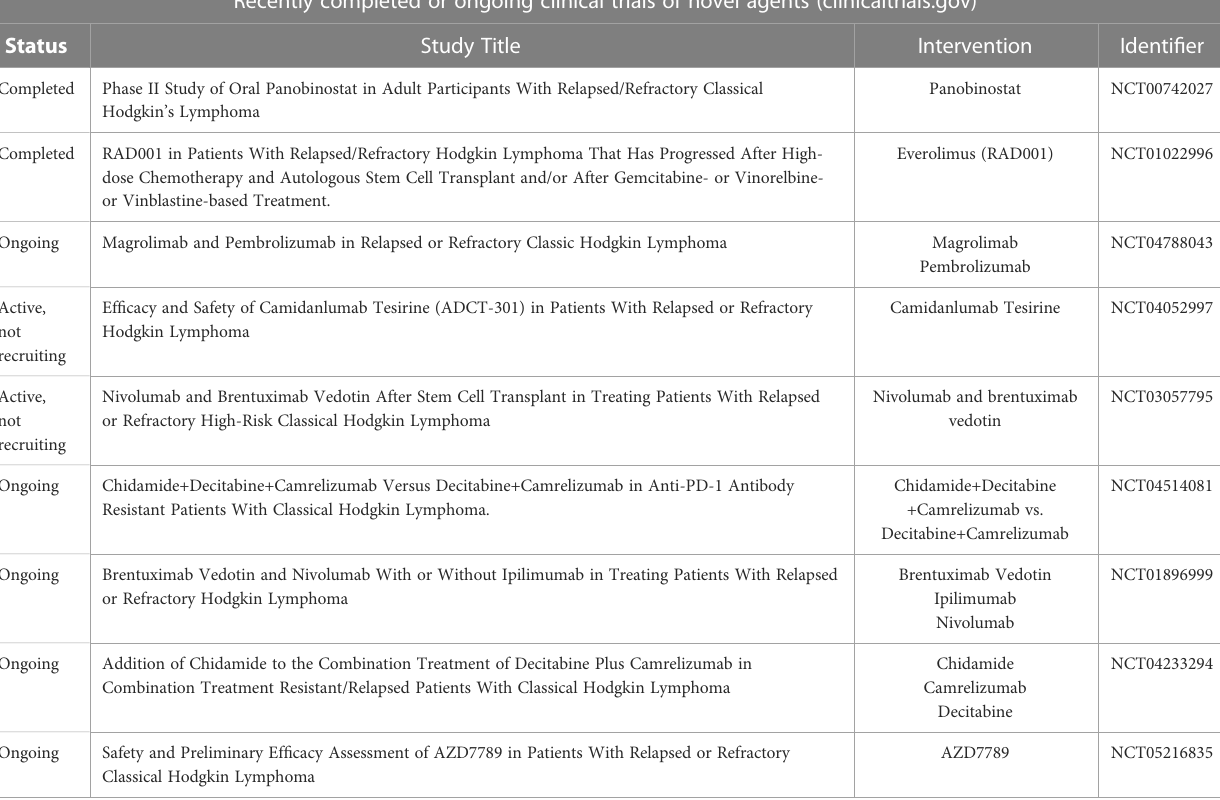
TABLE 3 Summary of clinical trials of novel agents in relapsed and refractory